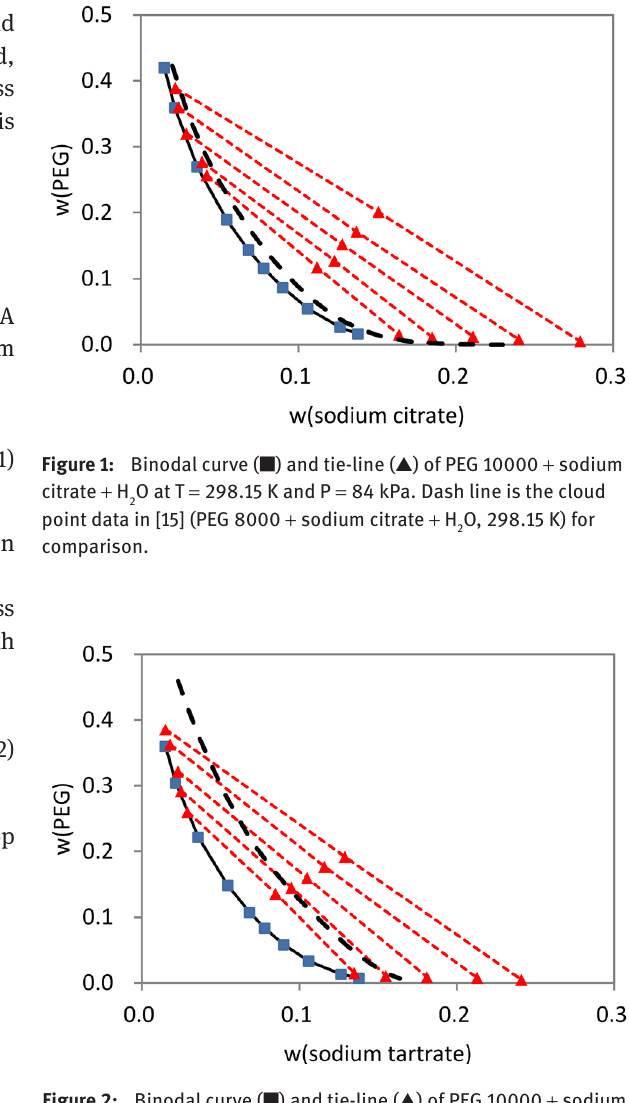
O, 298.15 K) for 2